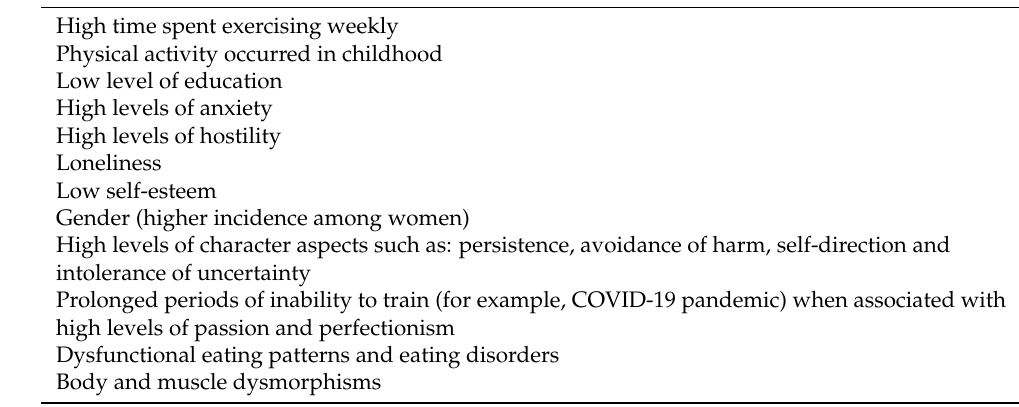
Table 2. Individual and situational factors and possible predictors of exercise addiction development. EXERCISE ADDICTION: INDIVIDUAL AND SITUATIONAL